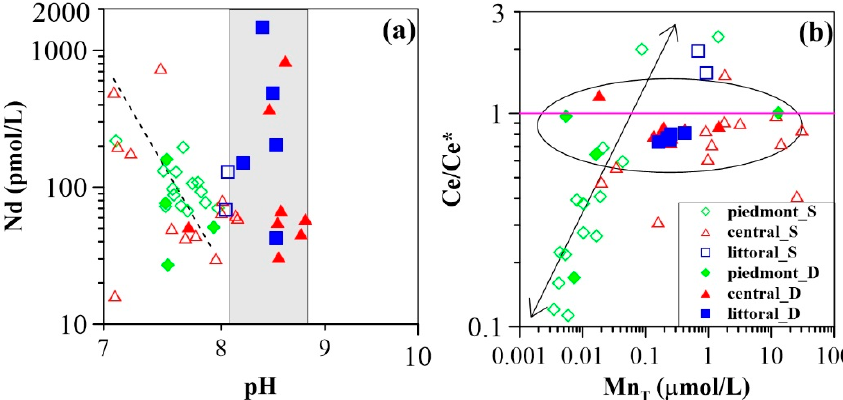
Figure 7. Concentrations of Nd as a function of pH ( a ); cerium anomaly (Ce/Ce*) as a function of Mn T ( b